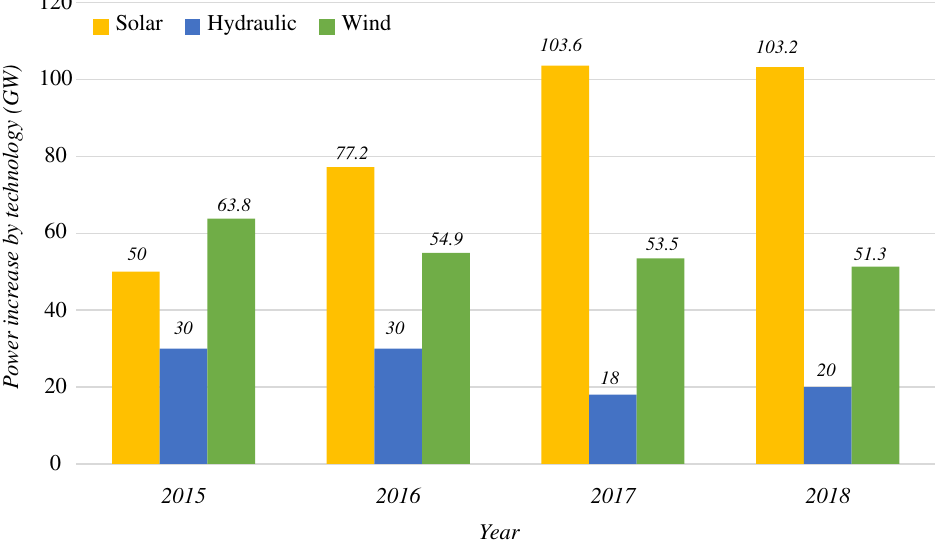
Figure 1. Annual increase in electricity generation capacity from RES by